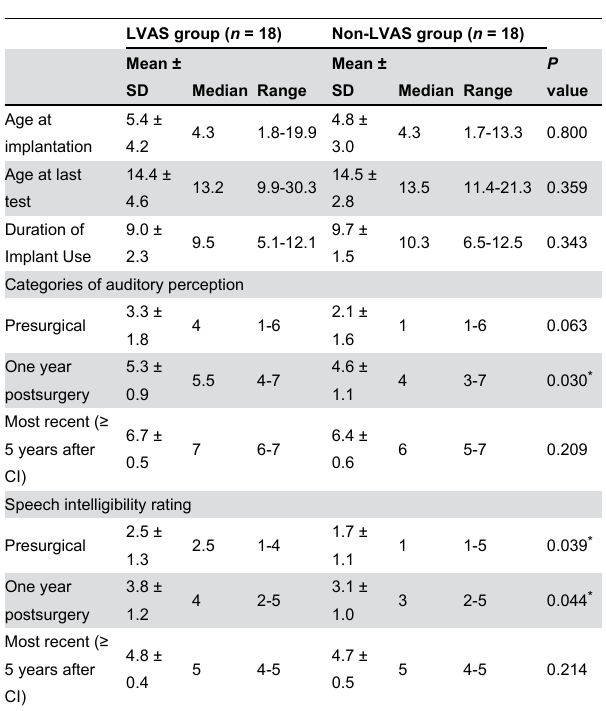
Table 3. Background information and the categories of auditory perception and speech intelligibility rating results between the LVAS and non-LAVS